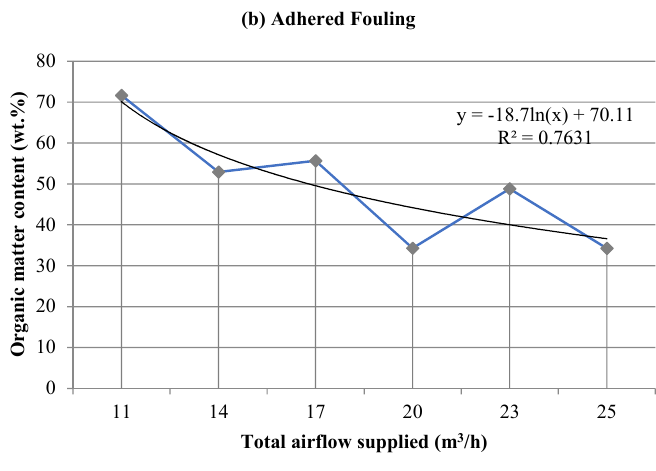
Figure 5. Organic matter content in fouling samples, namely “deposited fouling” ( a ) and “adhered fouling” ( b ) for different total airflows. Combustion parameters: 3 h of stable combustion and an airflow distribution of 25% and 75% in the primary and secondary airflow. Results of deposited fouling ( a ) better fitted with a polynomial curve of order 2, while results from adhered fouling ( b ) better fitted with a logarithmic